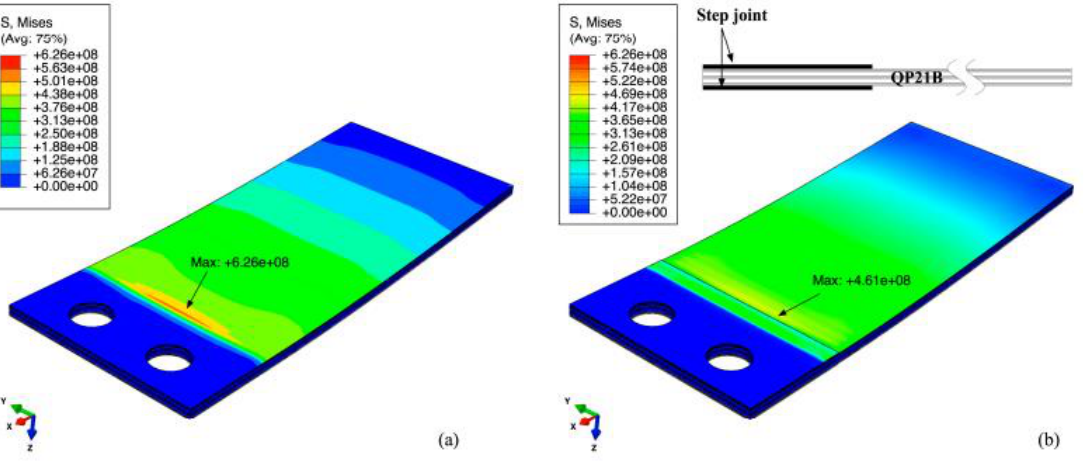
Figure 14. The von Mises stress dispersion of armored QP21B with no need for a stepped joint; ( a ) over stepped-jointed armored QP21B; ( b ) a raised junction has a similar thickness as the shielding layer of stainless steel (t = 0.0508 mm) [200].